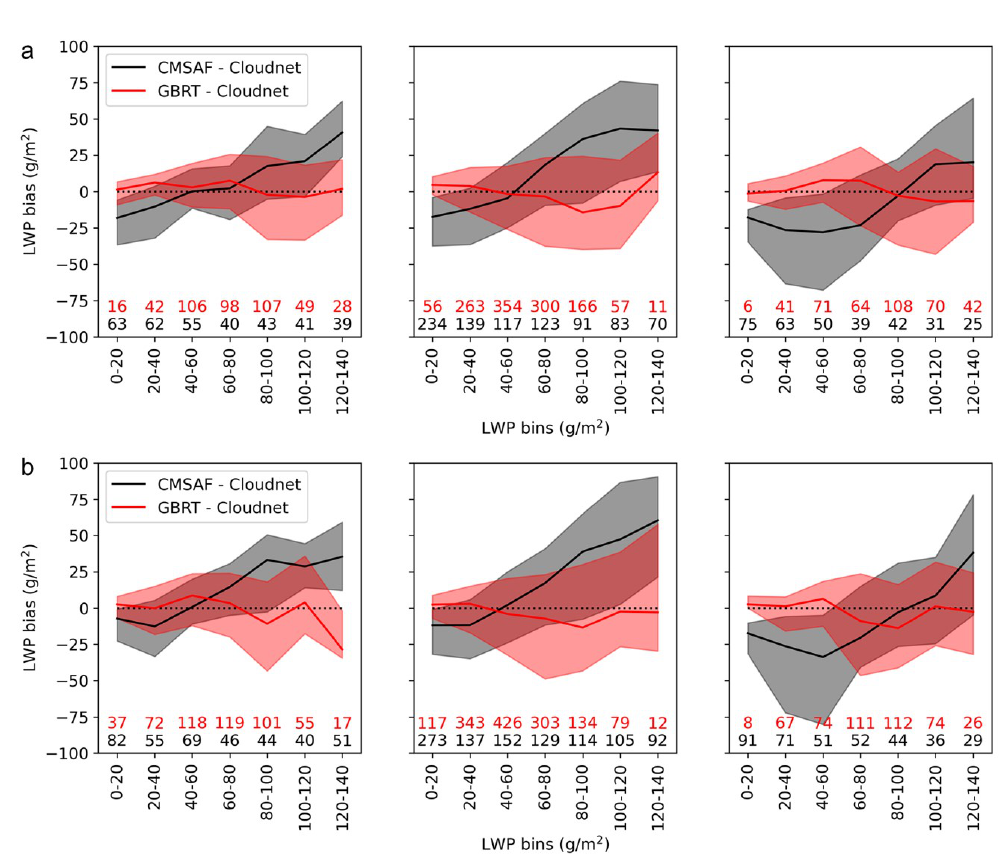
Figure 2. Median and interquartile range of biases between CloudNet LWP binned by LWP predicted by the GBRT model (red) and CM SAF (black) for: ( a ) homogeneous cloud fields; and ( b ) inhomogeneous ones without feature selection for Leipzig ( left ), Lindenberg ( middle ), and Juelich ( right ), respectively. Numbers at the bottom of the panels state number of